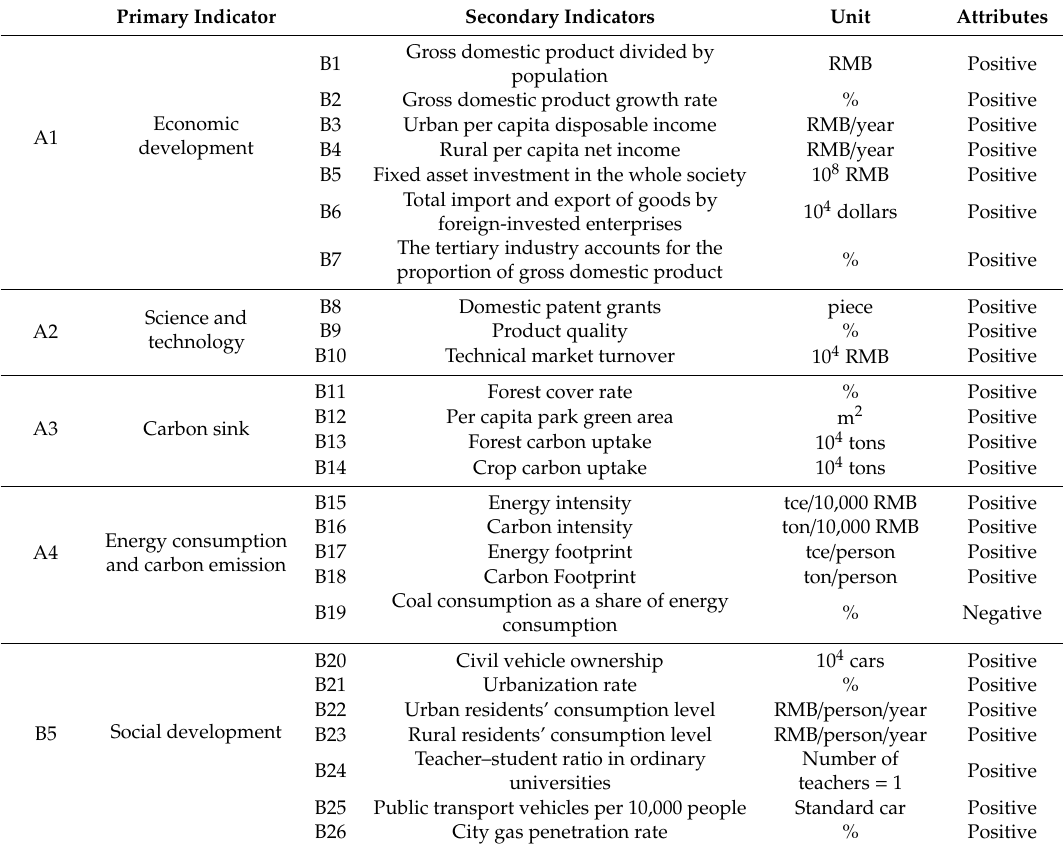
Table 2. Carbon emission reduction capacity (CERC) evaluation index